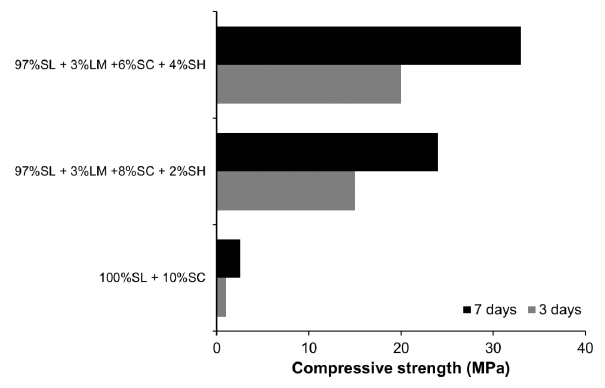
Figure 11: Effect of hybrid additive on compressive strength (adapted from